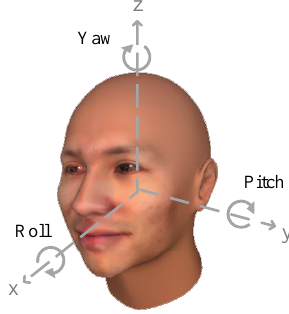
Figure 5. Three degrees of freedom of head